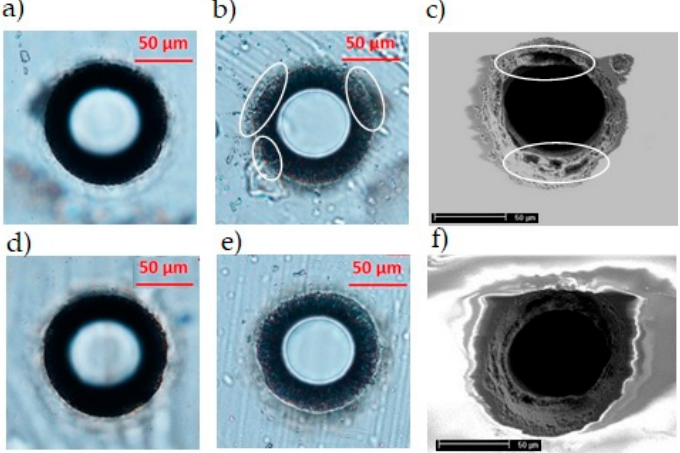
Figure 9. Through-holes generated in one pass and with a pulse energy of 130 μ J, in a 200 μ m- thick AF32 glass, respectively without (top row) and with (bottom row), the adhesive layer of Kapton tape stuck on the bottom surface. ( a , d ) and ( b , e ) are optical microscope images of the top and bottom surfaces, respectively, while ( c , f ) are SEM planar view images of the bottom surfaces recorded after a KOH chemical etching. The white marks in ( b , c ) highlight the irregularities and explosions at a microscopic scale due to the strong ablation of the surface sample at the glass–air interface, and evidently reduced in the case of micromachining with the adhesive tape (see ( e , f